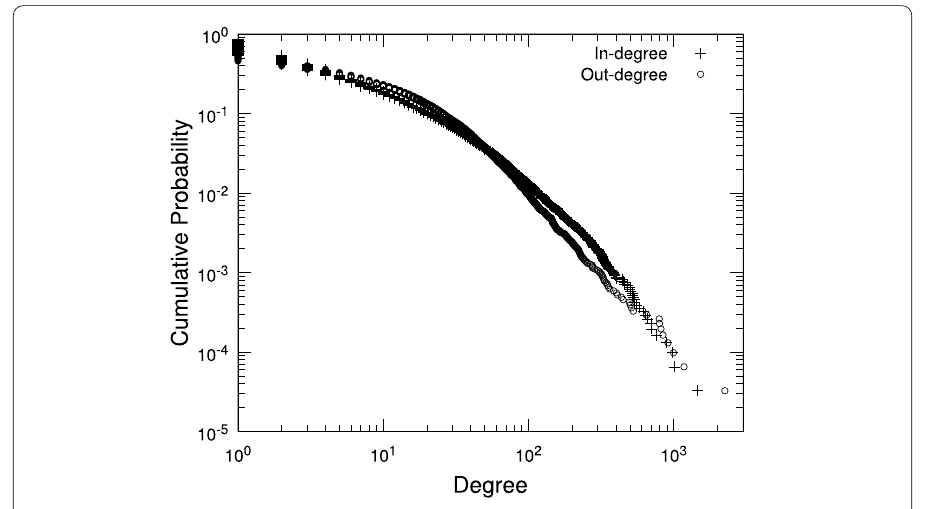
Figure 2 Degree distributions for the bank transfer network. Complementary cumulative distributions for in-degree and out-degree, which refer to the number of incoming and outgoing links, respectively, of